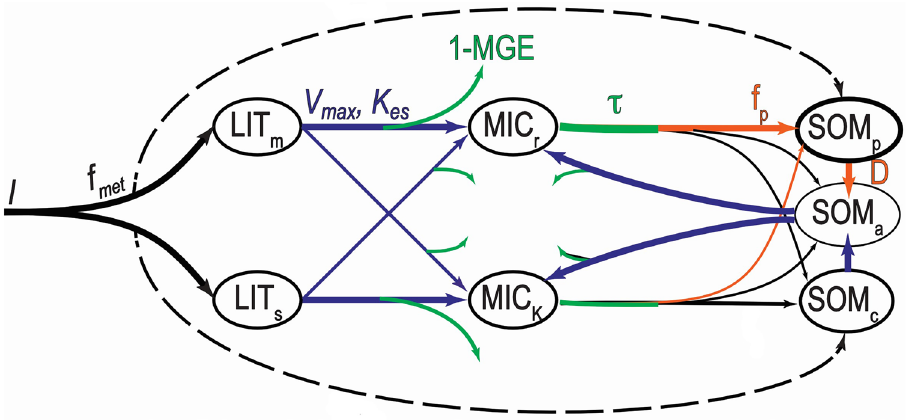
Figure 1. Diagram of the MIcrobial-MIneral Carbon Stabilization (MIMICS) model, which explicitly considers microbial functional diversity by simulating two functional groups (MIC r , inefficient, fast-growers; MIC K , conservative, slow-growers) and their potential effects on litter decomposition and soil organic matter persistence (available SOM a ; chemically protected SOM c ; physically protected SOM p ). Litter C inputs are initially partitioned (f met ) between litter pools (structural LIT s ; metabolic LIT m ), while a lesser fraction (f i ) transfers directly to the SOM pools. Parameters used for model calibration and validation related to microbial catabolic capacity (V max and K es , blue lines), microbial anabolism (MGE and τ, green lines), and physicochemical protection of SOM (f p and D, orange lines). See also Table